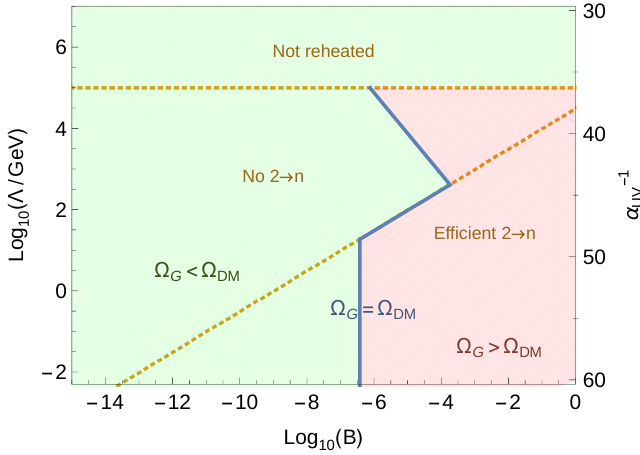
Figure 2 . The glueball DM parameter space for an SU (3) hidden sector with a period of late time matter domination and a low (cid:12)nal reheat temperature, due to a gravitationally coupled modulus with mass m X = 10 5 GeV. The correct relic density is indicated by a blue line and requires a modulus branching ratio to the glueball sector B signi(cid:12)cantly smaller than 1, but less extreme